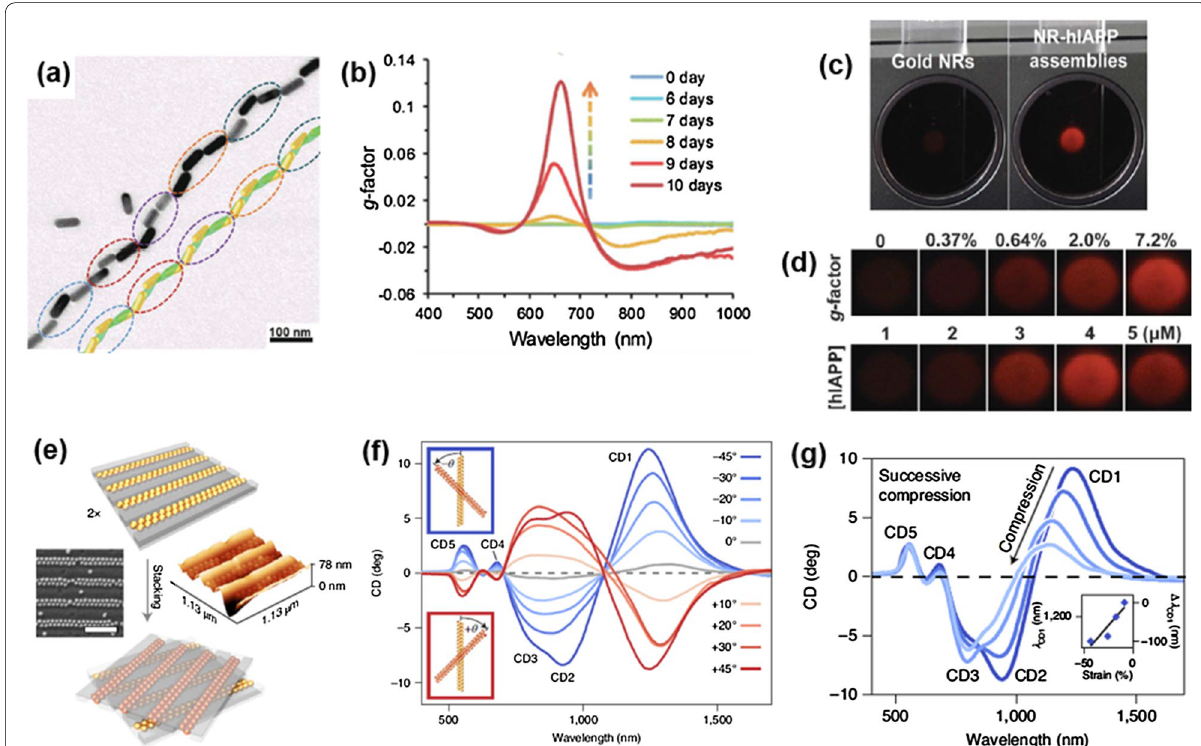
Fig. 11 a TEM image of NR-hIAPP helical assembly and reconstructed model from the TEM image. Pitch of the nanohelices were represented by the circles. b g-factor spectra for the coassembly process of hIAPPs with AuNRs. The g-factor reached to 0.12 after the coassembly completed. c Photographs of the red light transmitted through pure NR (left) and NR-hIAPP assemblies (right) under cross-polarized conditions. d Photographs of the red light transmitted through NR-hIAPP assemblies with different g-factors (top) and coassembled from various hIAPP concentrations (bottom). Reproduced with permission from [15]. Copyright 2021 AAAS. e Schematic image of stacking process and SEM and AFM height images of AuNP assembled into dimer chains inside nanochannels. Scale bar, 500 nm. f CD spectra for the chiral metasurfaces with stacking angles from over 30°, 20° and 10° to 0°. g CD spectra for the chiral metasurfaces stacked at ± ± ± with permission from [74]. Copyright 2021 Nature Publishing